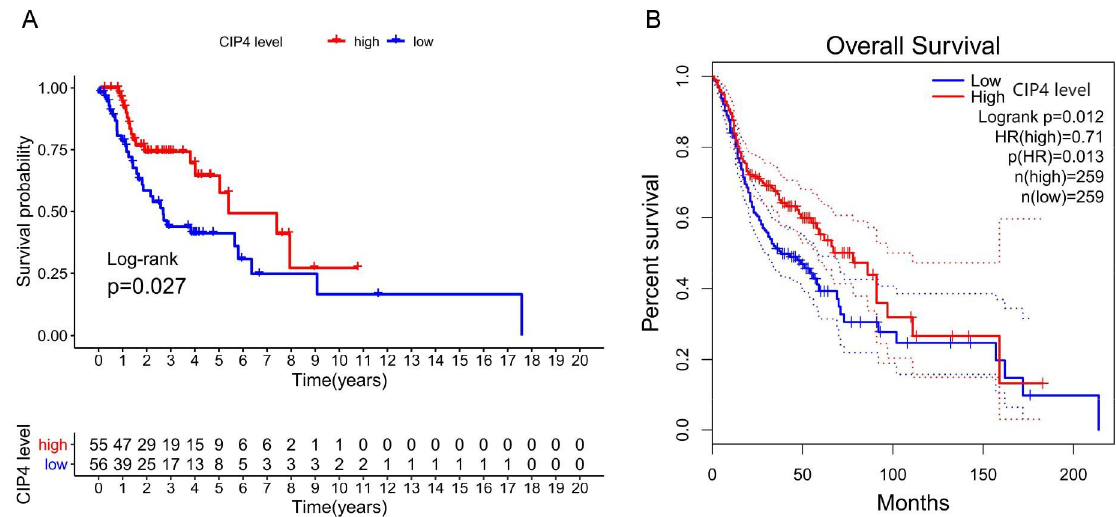
Fig 2. (A) Impact of CIP4 expression on overall survival in LC patients in TCGA cohort; (B) Impact of CIP4 expression on overall survival in GEPIA database.